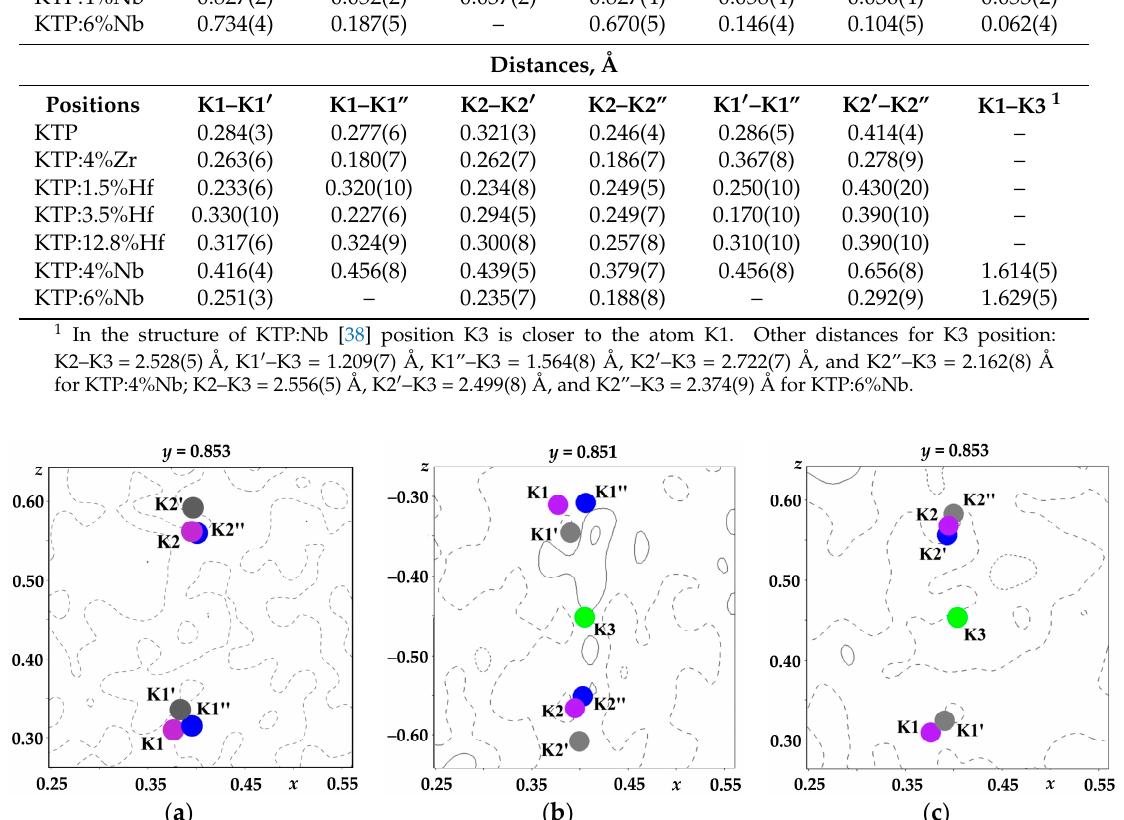
Table 6. Occupancies of potassium atomic positions and distances between these positions in the structure of pure KTP [46], KTP:4%Zr [36], KTP:1.5%Hf, KTP:3.5%Hf, KTP:12.8%Hf [37], KTP:4%Nb, and KTP:6%Nb [38].